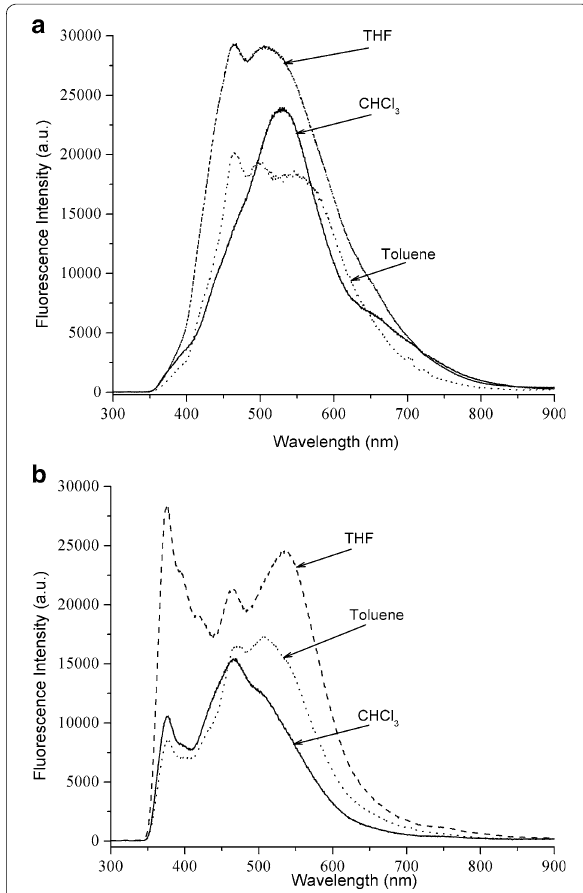
Fig. 8 Fluorescence spectra of PBDP3HTTPA ( a ) and PBDP3HTTPB ( b ) (concentrations of 0.05 g L − 1